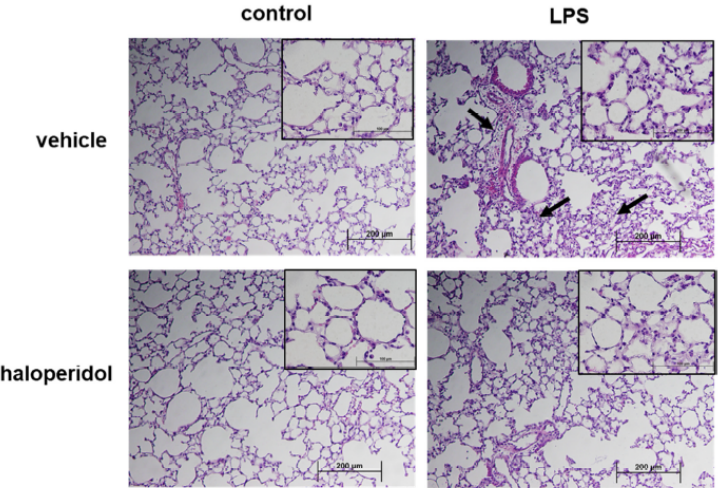
Figure 7. Murine ALI is attenuated by haloperidol: lung histology. Mice were pretreated with haloperidol (4 mg/kg, IP) or vehicle 24 h prior to repeat treatment of the same followed by the administration of intratracheal LPS (1.25 mg/kg). Lungs were harvested and utilized for histology evaluation. LPS-induced inflammatory cell infiltration and interstitial edema (arrows) was less evident in animals that were pre-treated with haloperidol (representative 10× images shown with 40× inset).